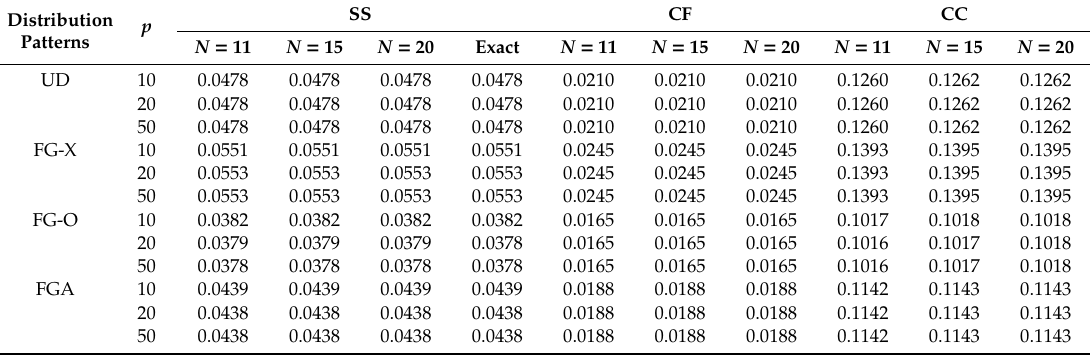
Table 4. Convergence study of the fundamental frequencies of FG-GPLRC circular arch.